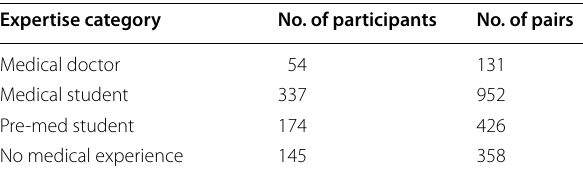
Table 6 Number of participants in each expertise group and the number of condition pairs contributed by the groups Expertise category No. of